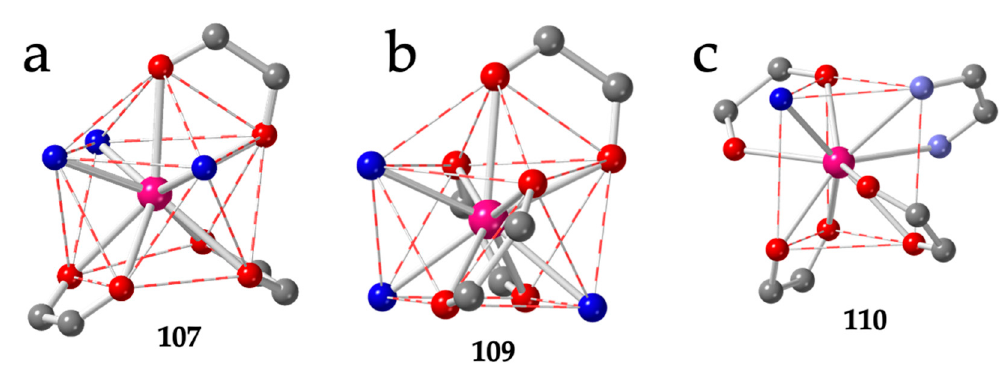
Figure 14. ( a ) View of the coordination environment of the Nd(III) ion in compound 107 . ( b ) View of the coordination environment of the Nd(III) ion in compound 109 . ( c ) View of the coordination environment of the Eu(III) ion in compound 110 . Colour code: Ln = pink, C = grey, O anilato = red, O solvent = blue and N bipym = light blue.